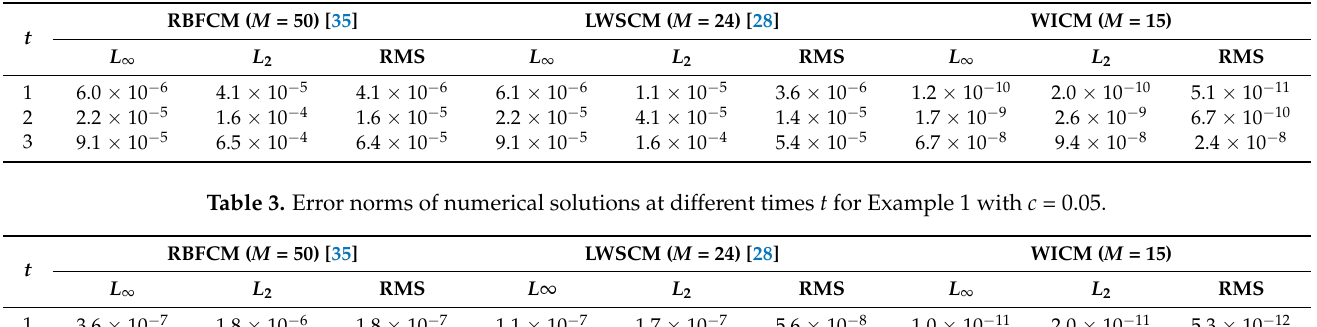
Table 2. Error norms of numerical solutions at different times t for Example 1 with c = 0.5.